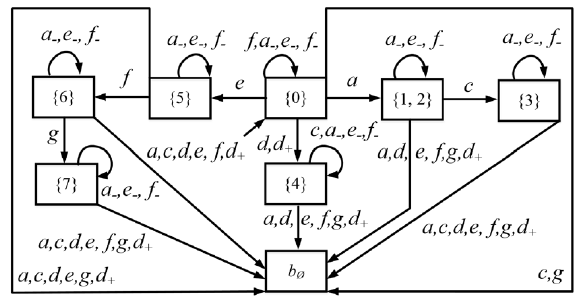
Figure 4. Operator observer in Example 12 for the plant in Fig. 2.